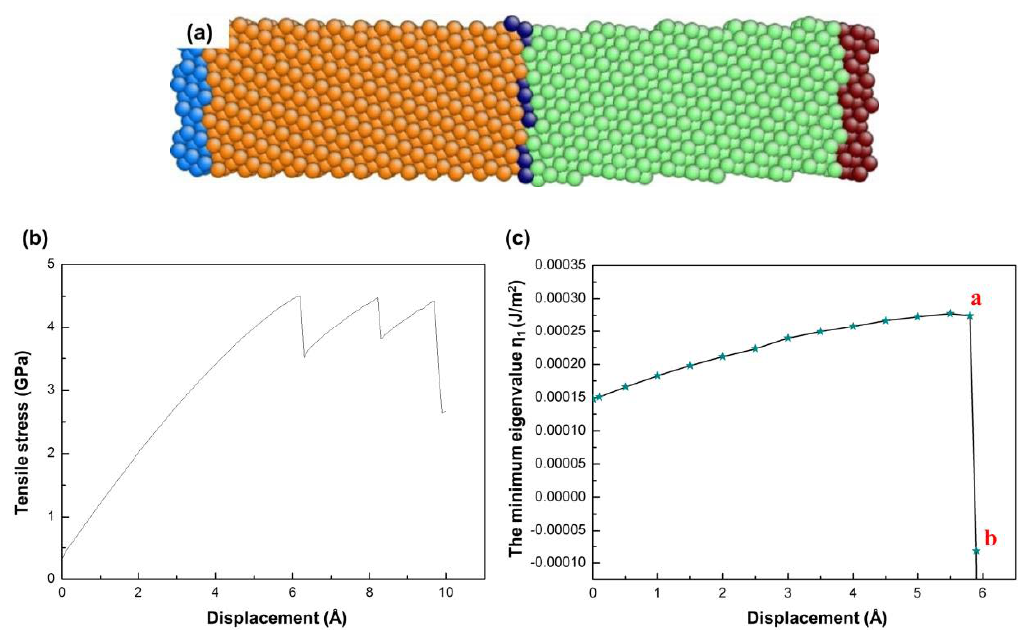
Figure 10. ( a ) Atomic structure of the bicrystalline model C with an asymmetric tilt grain boundary. ( b ) Plot of tensile stress vs. displacement. ( c ) Plot of the calculated minimum eigenvalue ( η 1 ) of matrix A vs. displacement.